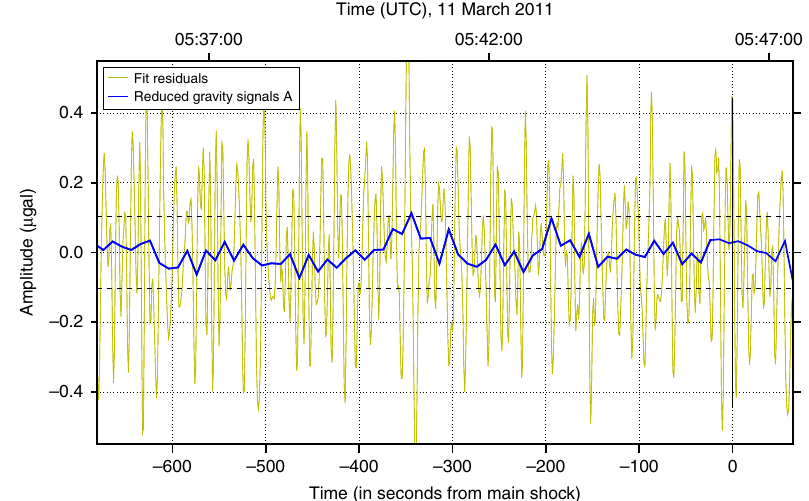
Figure 2 | Time series of residuals and reduced gravity signal. Yellow line: residuals obtained from least squares polynomial fit ( d ¼ 2, T ¼ 690s). Blue line: reduced gravity signal A around the occurence of the Tohoku-Oki earthquake (vertical solid line). The horizontal dashed lines indicate (cid:4) A Tohoku j j . The A value exceeding the upper dashed line near (cid:2) 350s is considered an